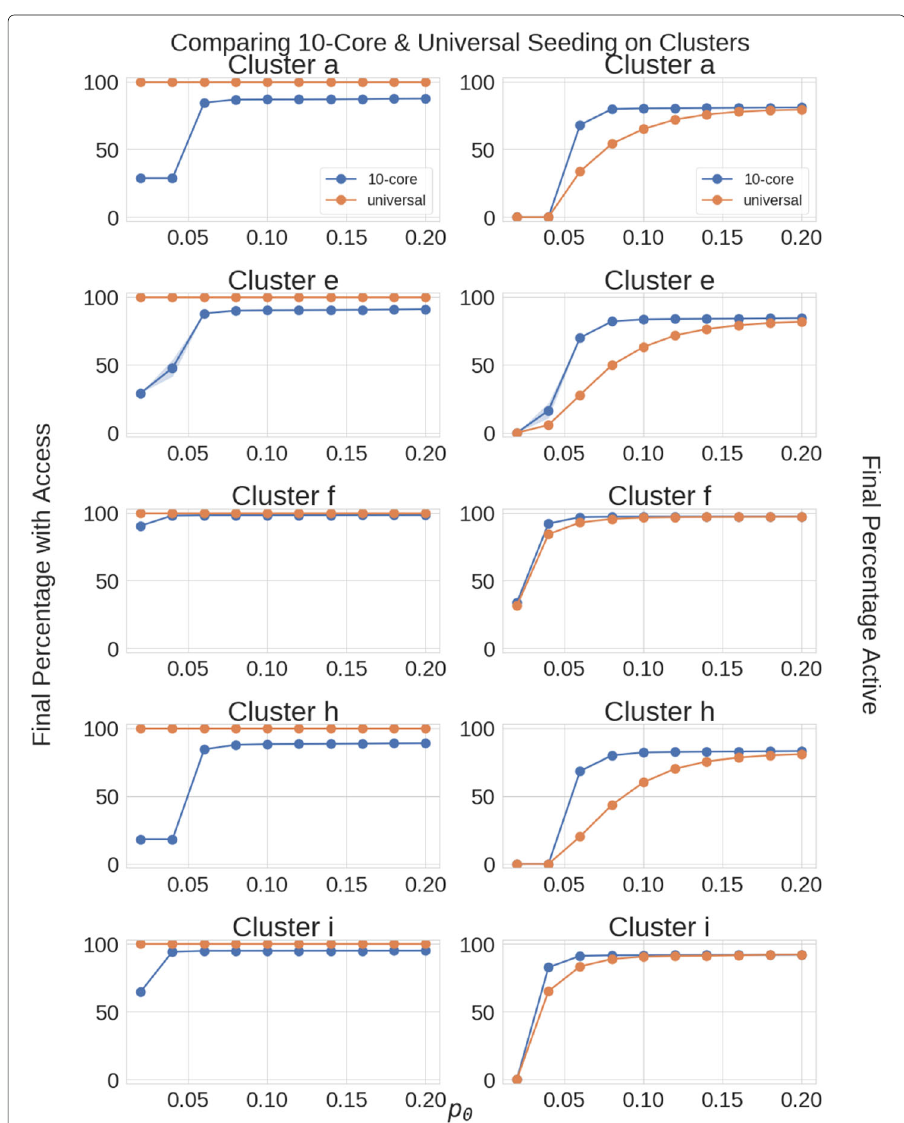
Fig. 5 Comparison of 10-core and universal seeding in the repeated-usage model. Different rows correspond to different SH clusters from Table 1. The left-hand column shows the average asymptotic percentage of the population with access; the right-hand column shows the average asymptotic percentage that is active. Legends are shared by the left and right panels in each row. The parameters s i = 2 and δ = 0.005 in these simulations. Each data point is an average over 50 simulations